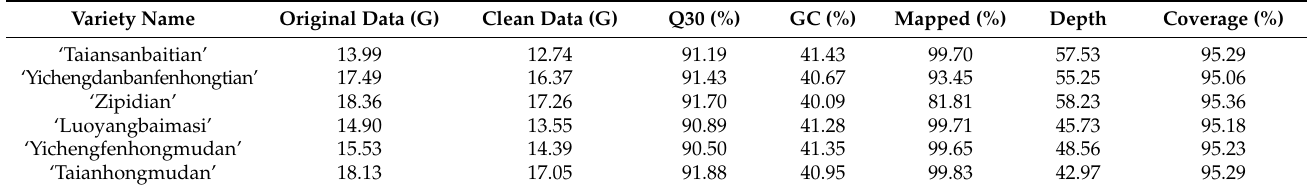
Table 2. Summary of the sequencing data of 6 ornamental pomegranate varieties.